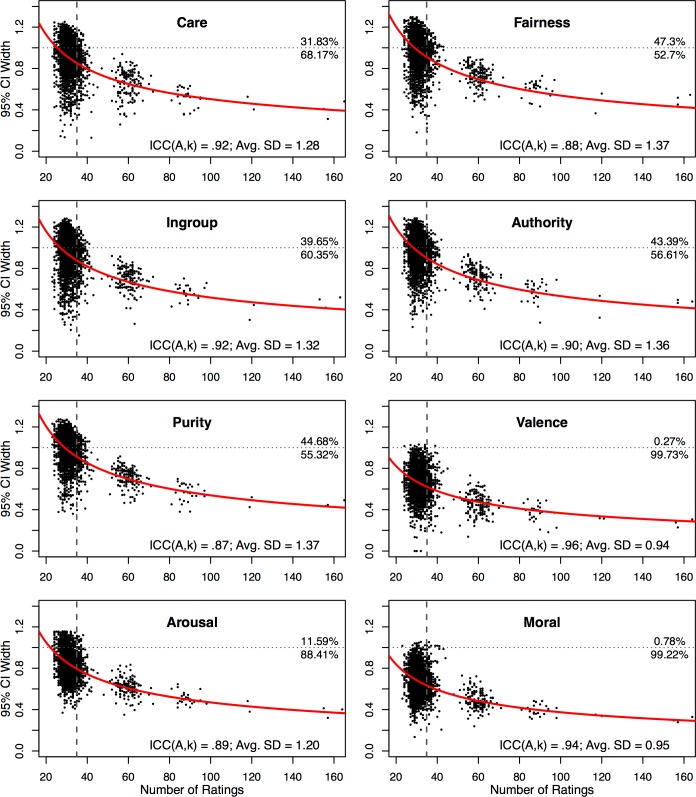
Scatterplots of image norm 95% confidence interval (CI) widths as a function of the number of ratings, by dimension.Each point represents an individual image. Vertical axis represents 95% CI width (in scale points) for each image, with images lower on the axis having more precise measurement. Horizontal axis represents the number of times each image has been rated. Red curve represents expected 95% CI width given the average rating SD (inset) for that dimension and number of ratings. Vertical dashed grey line represents average number of ratings per image for that dimension. Horizontal dotted grey line marks a 95% CI width of 1, with the percentage of images falling above or below this threshold presented at the right end of the line. ICC(A,k) (inset) represents the average ICC(A,k) across batches.